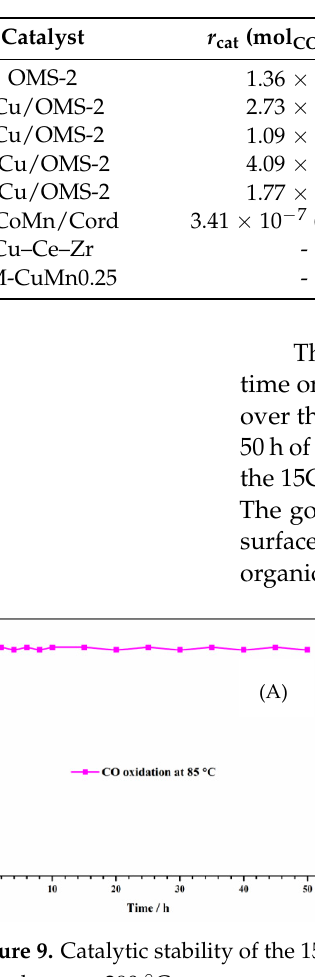
Table 4. A consumption on specific reaction rates for the oxidation of CO at 70 ◦ C, ethyl acetate at 180 ◦ C, and toluene at 260 ◦ C over the OMS-2 and x Cu/OMS-2 samples.